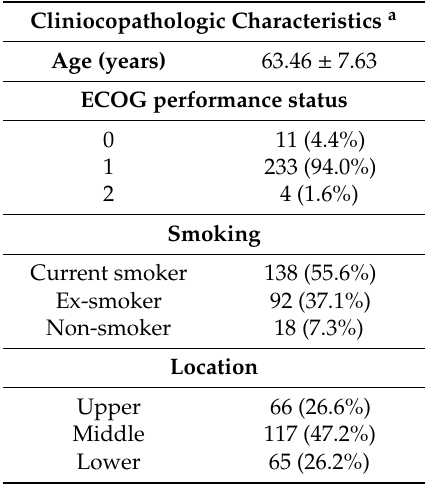
Table 1. Patient characteristics, with baseline laboratory test results ( n =